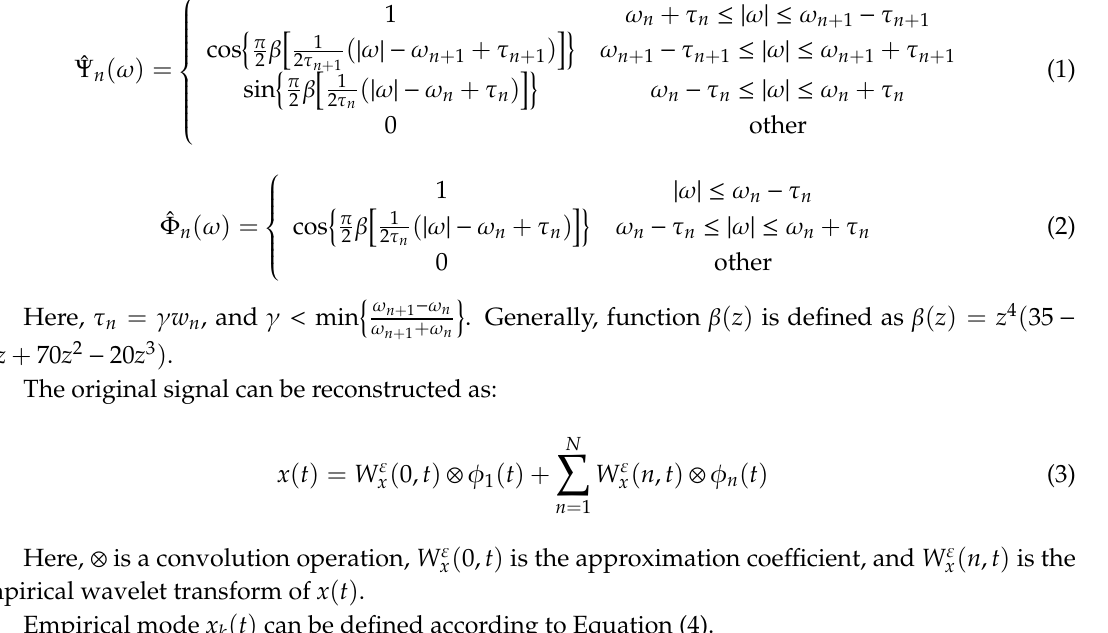
Figure 2. NARX network structure diagram.